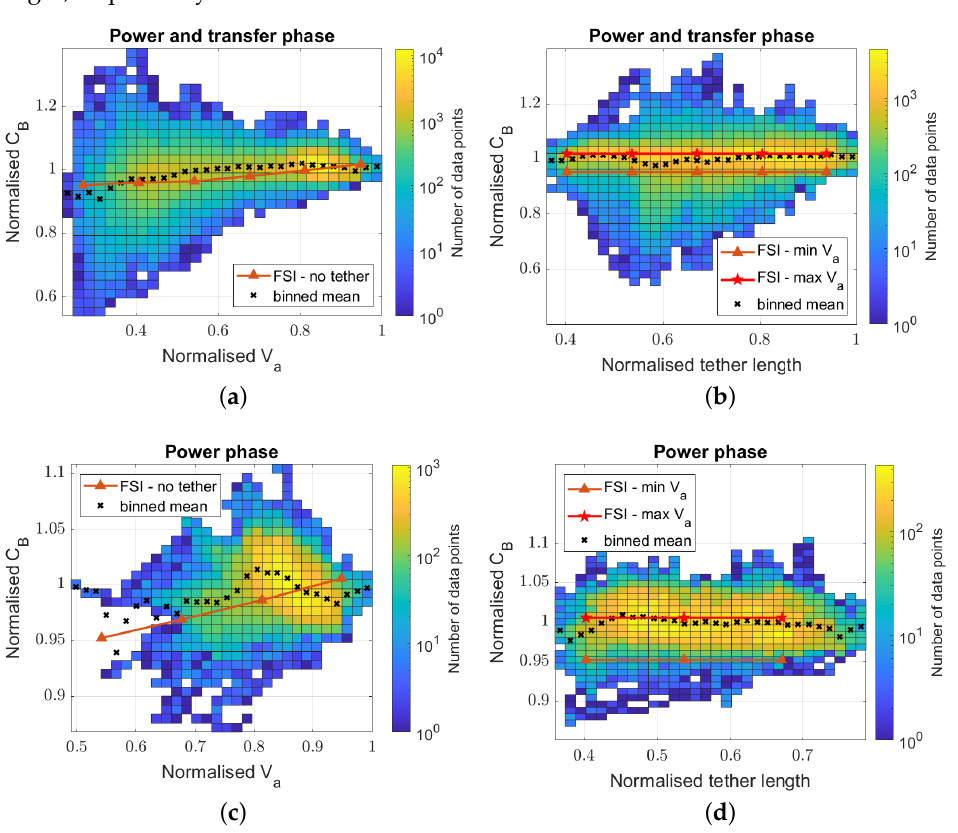
Figure 11. Normalized steering belt force coefficient for various apparent wind speeds obtained during a total of 154 power cycles [20]. ( a ) C B against V a . ( b ) C B against tether length. ( c ) C B against V a . ( d ) C B against tether